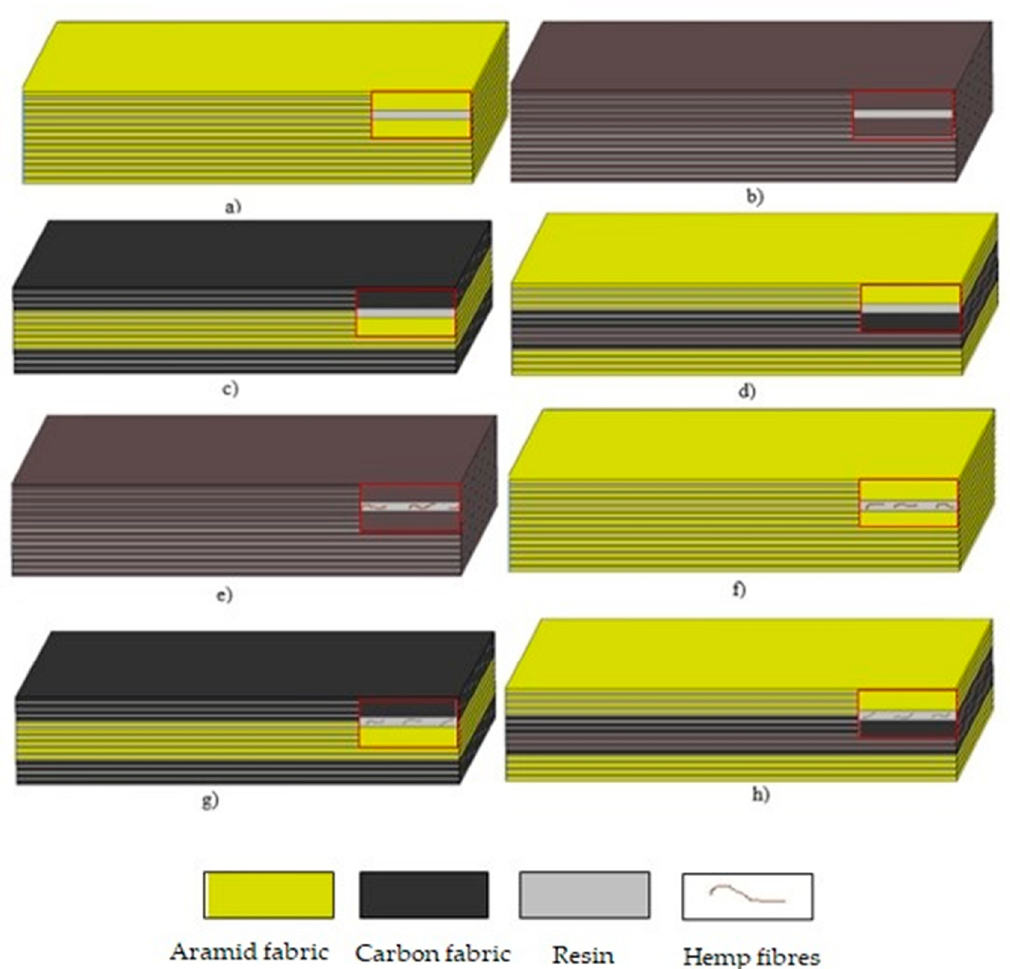
Figure 3. Non-hybrid ( a , b ) and hybrid ( c – h ) configurations of composite laminates.